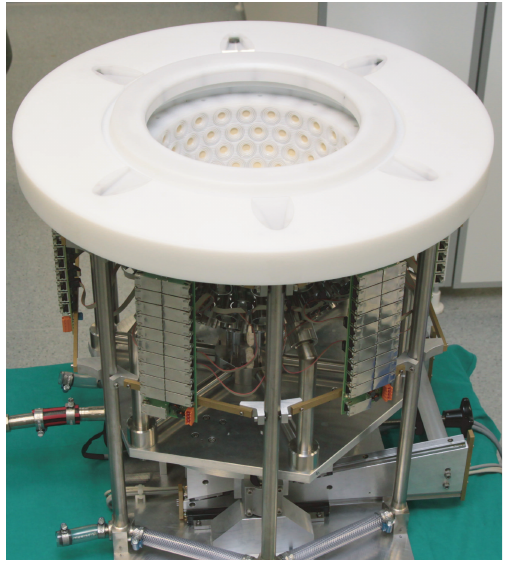
Figure 1: Image of the semiellipsoidal aperture of the new 3D USCT II. It is equipped with 628 ultrasound senders and 1413 receivers, grouped into 157 transducer array systems, mounted at the inner surface of the measurement